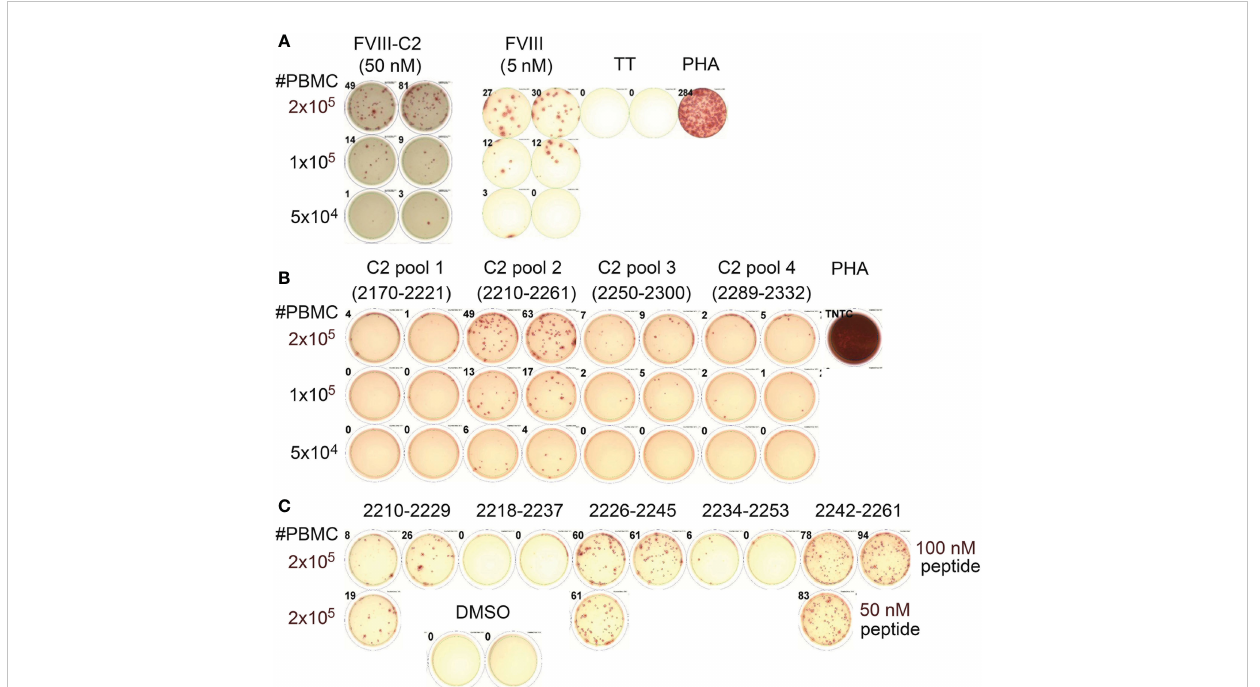
FIGURE 2 Mapping of CD4 + T-cell epitopes in the FVIII C2 domain by peptide ELISPOT assays (Int22Inv subject P1). (A) This subject ’ s PBMCs showed robust IFN- g secretion when stimulated with rFVIII and rFVIII-C2 proteins. The FVIII-C2 ELISPOTs were carried out on different plates and read separately, hence the different background color in this image. (B) Decoding of his response to the FVIII C2 domain using pools of 20-mer peptides spanning the C2 domain sequence indicated that C2 pool #2 contained one or more immunodominant epitopes. (C) Further decoding by stimulations with the individual 20-mer peptides comprising C2 pool 2 indicated that he had speci fi c responses to three epitopes in the FVIII C2 domain. His PBMCs did not respond to pooled peptides spanning the FVIII A2 domain (not